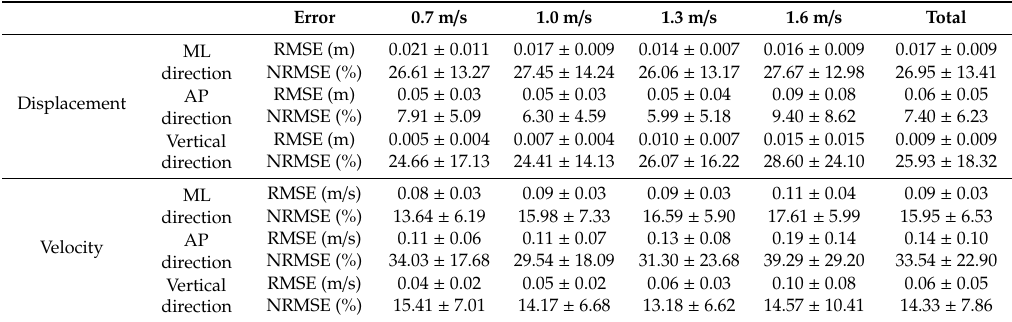
Figure 7. Estimation results and experimental data for the joint torque of ( A ) hip, ( B ) knee, and ( C ) ankle during the stance phase for all 17 participants. Ab / Ad, F / E (or E / F), ER / IR, and PF / DF represent abduction / adduction, flexion / extension (or extension / flexion), external rotation / internal rotation, and plantarflexion / dorsiflexion, respectively. The averages and the standard deviations of the estimation results are represented by black thick solid lines and black thin solid lines, respectively, and the averages and standard deviations of the experimental data are represented by a white thick solid line and gray shaded area, respectively. Table 2. Root-mean-square error (RMSE) and normalized RMSE of estimated displacement and velocity of the sacrum.